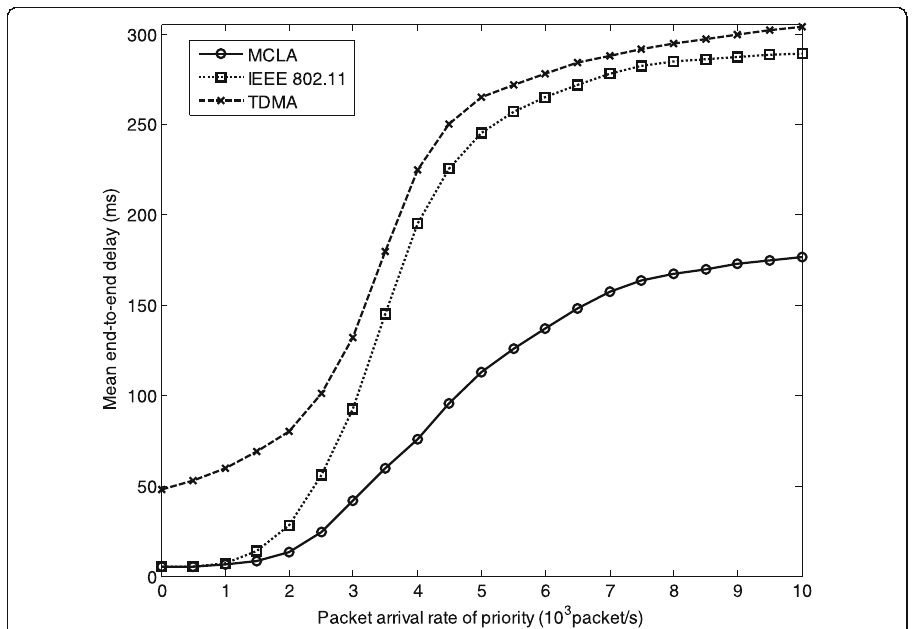
Fig. 10 Mean end-to-end delay of packets in different MAC